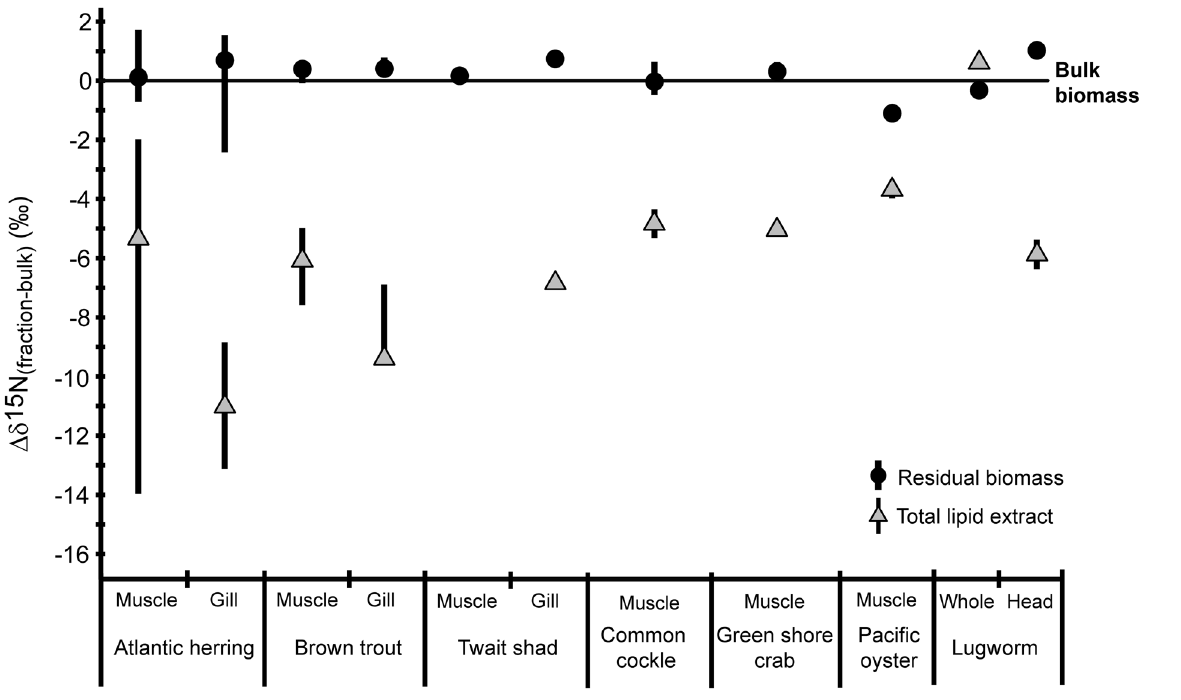
Fig 1. δ 15 N values of residual biomass, the total lipid extract and serine normalized to bulk biomass. Median values (symbols) and ranges of differences in δ 15 N of residual biomass, the total lipid extract (TLE) and serine compared to bulk biomass ( Δδ 15 N fraction-bulk ) for the different animals.